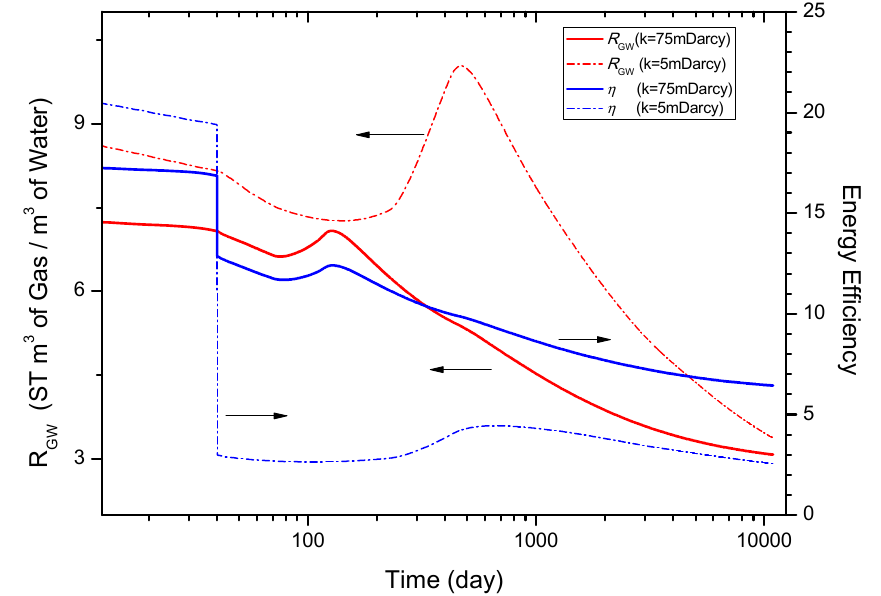
Figure 14. Evolution of the energy efficiency η , the gas-to-water ratio R dependence on the intrinsic permeability k of the hydrate reservoir during hydrate